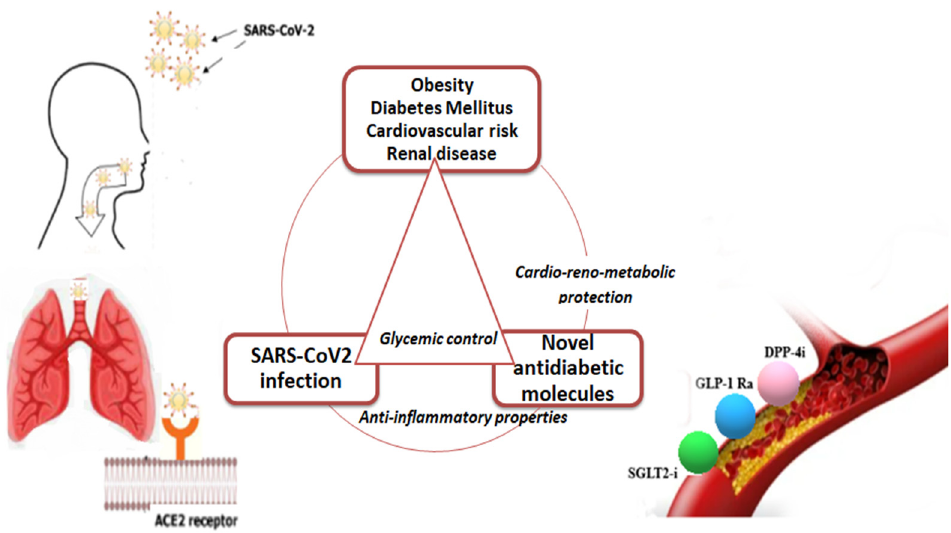
Figure 2. The implications and possible benefits of novel antidiabetic drugs in COVID.